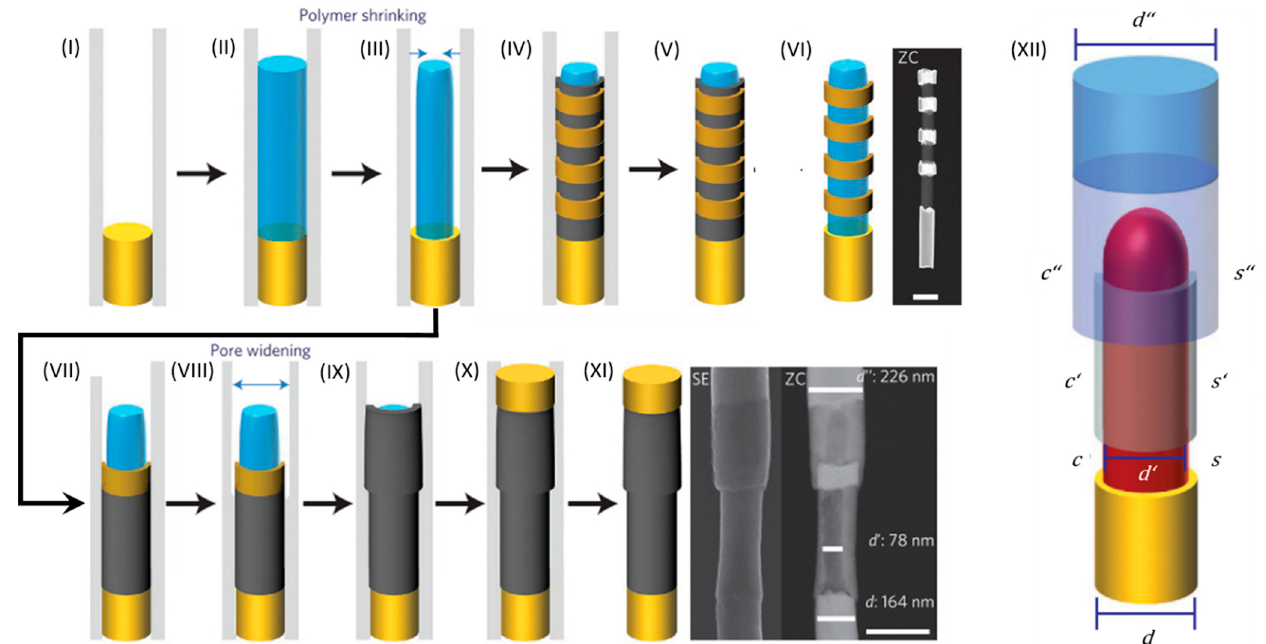
Figure 12. Coaxial lithography. ( I − V ) Scheme illustrating electrochemical synthesis of core–shell nanowires based on the controlled shrinking of the polymer core segment (shown in blue). ( VI ) Subsequent selective etching of sacrificial metal rings around the polymer core. ADF-STEM image of Au nanorings on a polypyrrole core. Scale bar is 500 nm. ( VII − XI ) Synthesis of core/shell/shell nanowires. After depositing shells around the polymer core, the pores of the tubular template are widened ( VIII ), and subsequent electrodeposition leads to the formation of core/shell/shell nanowires ( IX ). ( XI ) SE- and ADF-STEM image of a PANI core/Au ring/Ni shell nanowire. Scale bar is 250 nm. ( XII ) Scheme illustrating the geometrical and compositional parameters that can be controlled using COAL: diameters (d, d’, and d’’: from 20 nm to 400 nm), segment lengths (s, s’, and s’’: from 8 nm to a few micrometres) and compositions (c, c’, c’’, and polymers: PANI, PPy, PTh, and P3HT; metals: Au, Ag, Ni, Pt, and Pd; inorganic semiconductors: MnO2, CdSe, and CdS). Reprinted by permission ref. [30], Copyright 2015 Springer Nature.